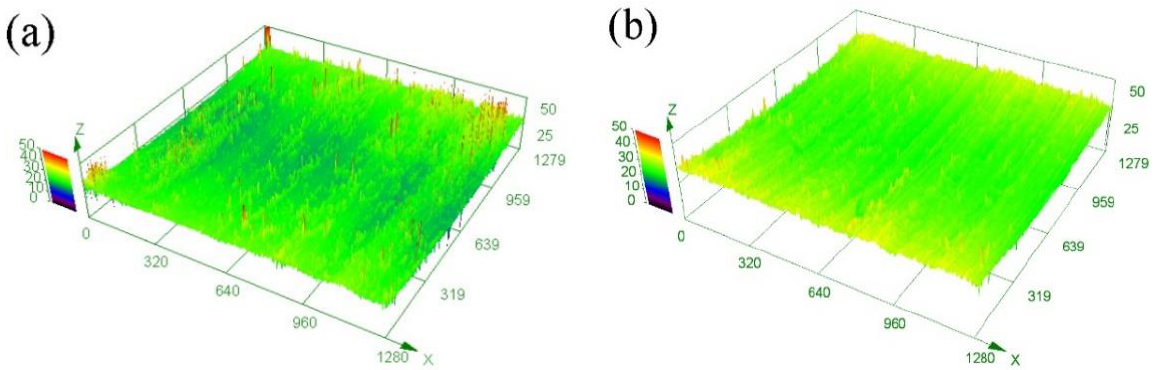
Figure 14. 3D laser morphologies of B-bearing high-speed alloy steel: ( a ) alloy A; ( b ) alloy B.